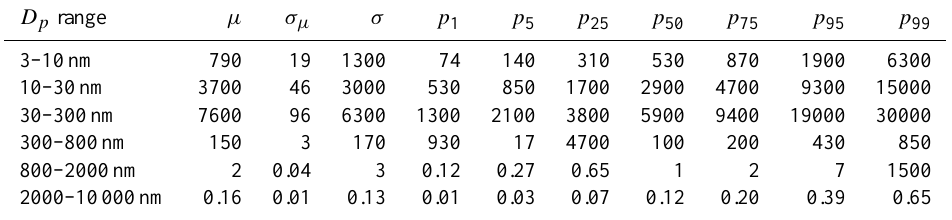
Table 1. Particle number concentrations in Augsburg for specific particle size intervals. µ indicates the arithmetic mean, σ the standard deviation, σ µ the standard deviation of the mean, and p k the k th percentile of the concentration in the corresponding size